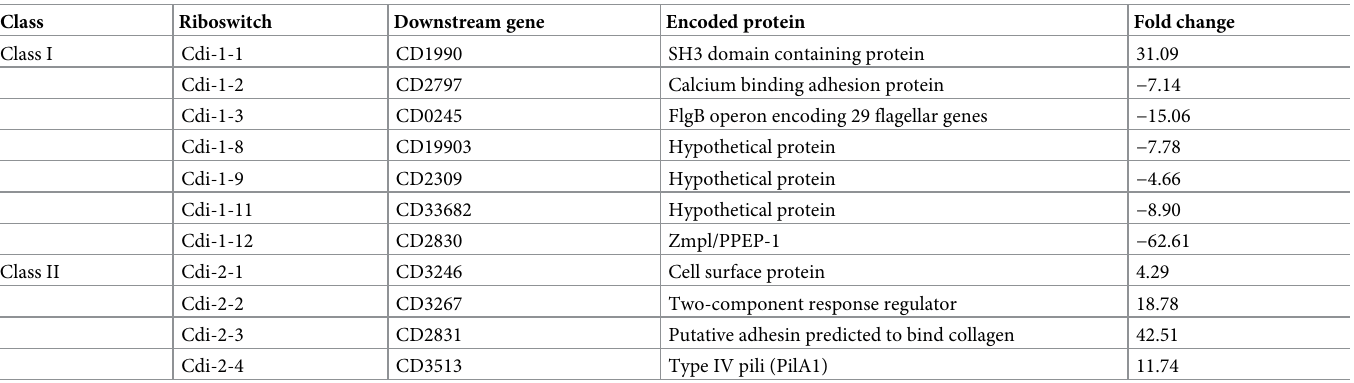
Fold changes in gene expression were measured by microarray analysis of planktonically grown 630 Δ erm expressing plasmid encoded pDccA compared to a vector control. Plasmid induced expression of dccA by 1 μ g/ml nisin was used to increase intracellular c-di-GMP levels. (Adapted from